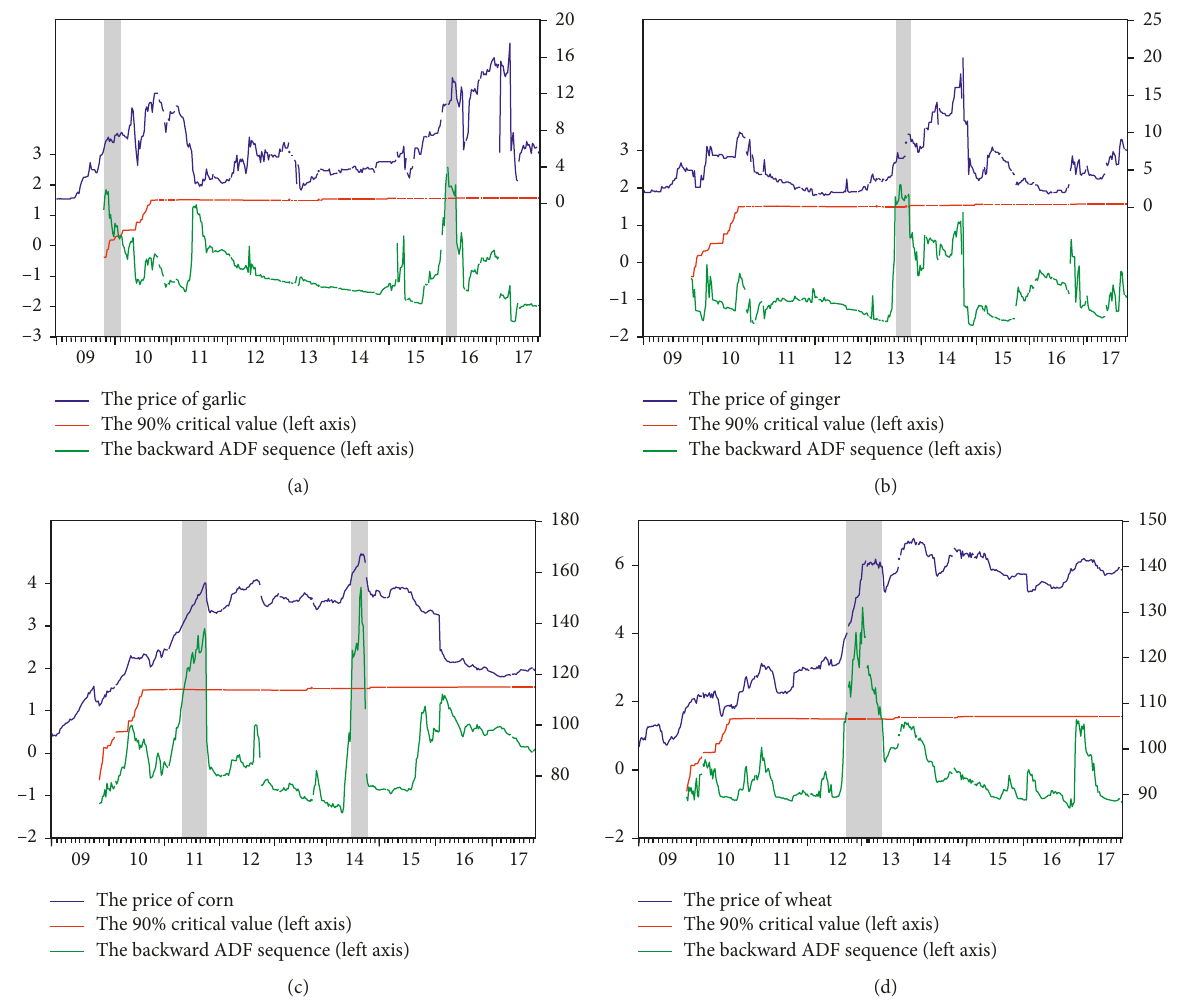
Figure 1: The GSADF test of the price of the agricultural market, including garlic, ginger, corn, and wheat markets.